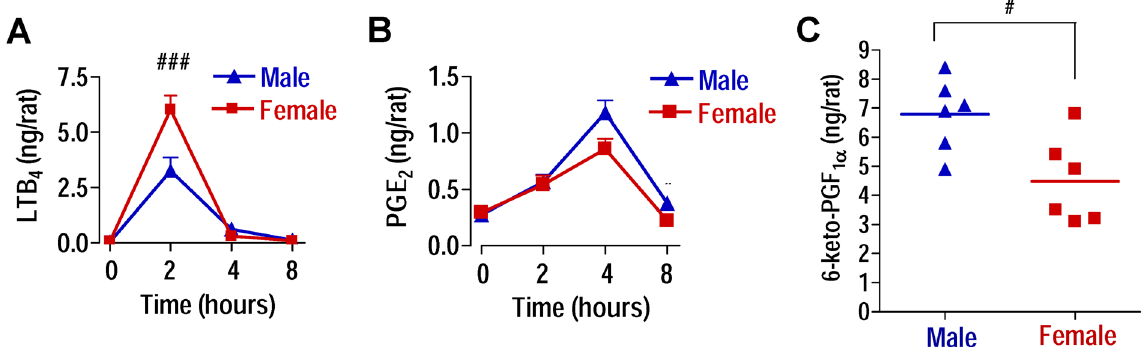
Figure 2. Sex differences in eicosanoid biosynthesis in carrageenan-induced pleurisy in rats. Rats were treated with carrageenan (intrathoracic injection), sacrificed at the given time points, and ( A ) LTB 4 and ( B ) PGE 2 in the thoracic exudates were measured by EIA and RIA, respectively. ( C ) 6-keto-PGF 1 α levels in thoracic exudates were measured 4 hrs after carrageenan injection by EIA. Time zero (T0) corresponds to untreated rats. Values represent means ± S.E.M; n = 6 rats/T0; n = 13 rats/2 hrs; n = 6 rats/4 hrs; n = 6 rats/8 hrs; # p < 0.05; ### p < 0.001, male vs female; two-way ANOVA plus Bonferroni ( A and B ) and two-tailed Student’s t test ( C